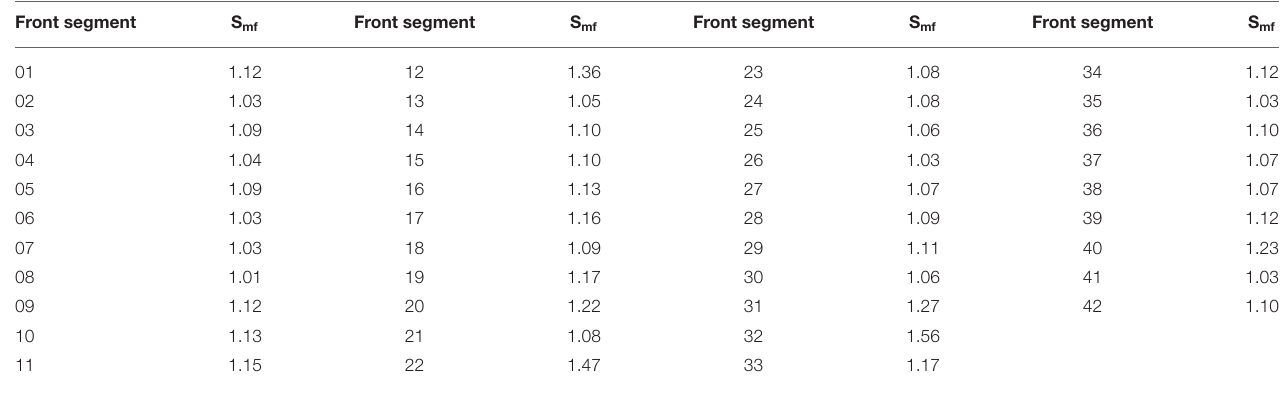
TABLE 2 | Mountain front sinuosity values calculated from mountain fronts in the upper reached of the Rambiara basin. Front